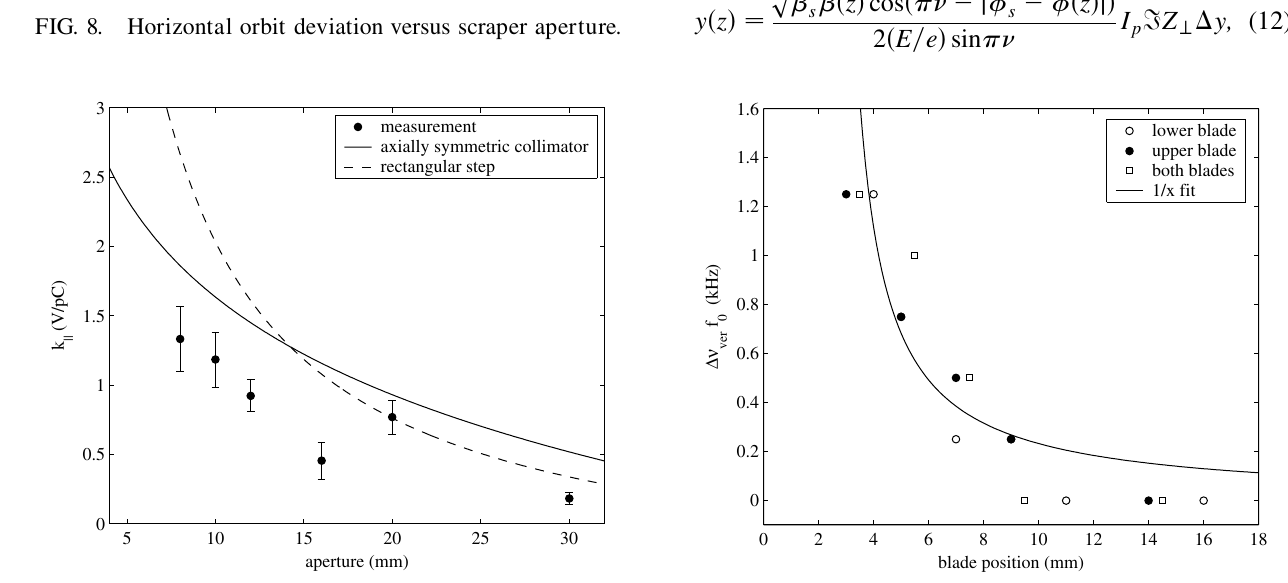
FIG. 9. Longitudinal loss factor caused by the scraper. FIG. 10. Tune shift versus scraper blades’